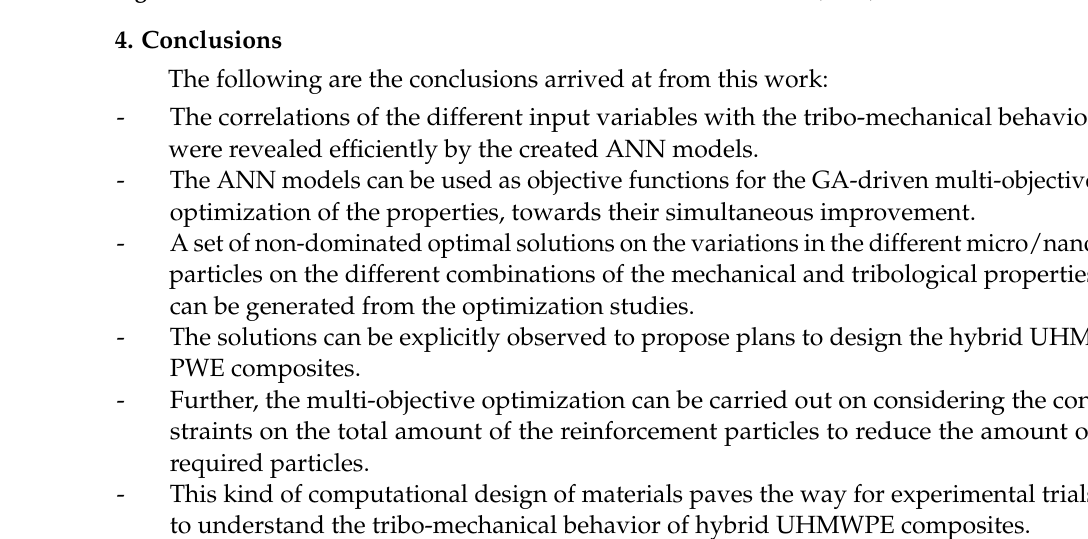
Figure 10. Deviation in the reinforcements in the Pareto solutions for H, CoF, and SWR.